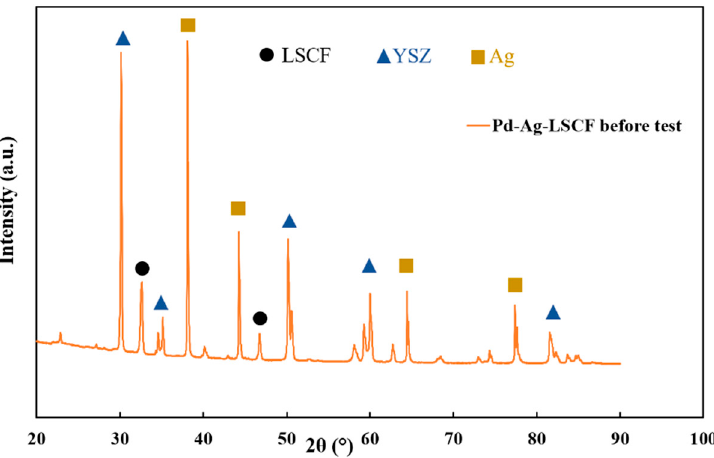
Figure 4. EDS map of Pd, Ag, Fe distribution and SEM image of Pd infiltrated Ag-LSCF anode surface before testing.